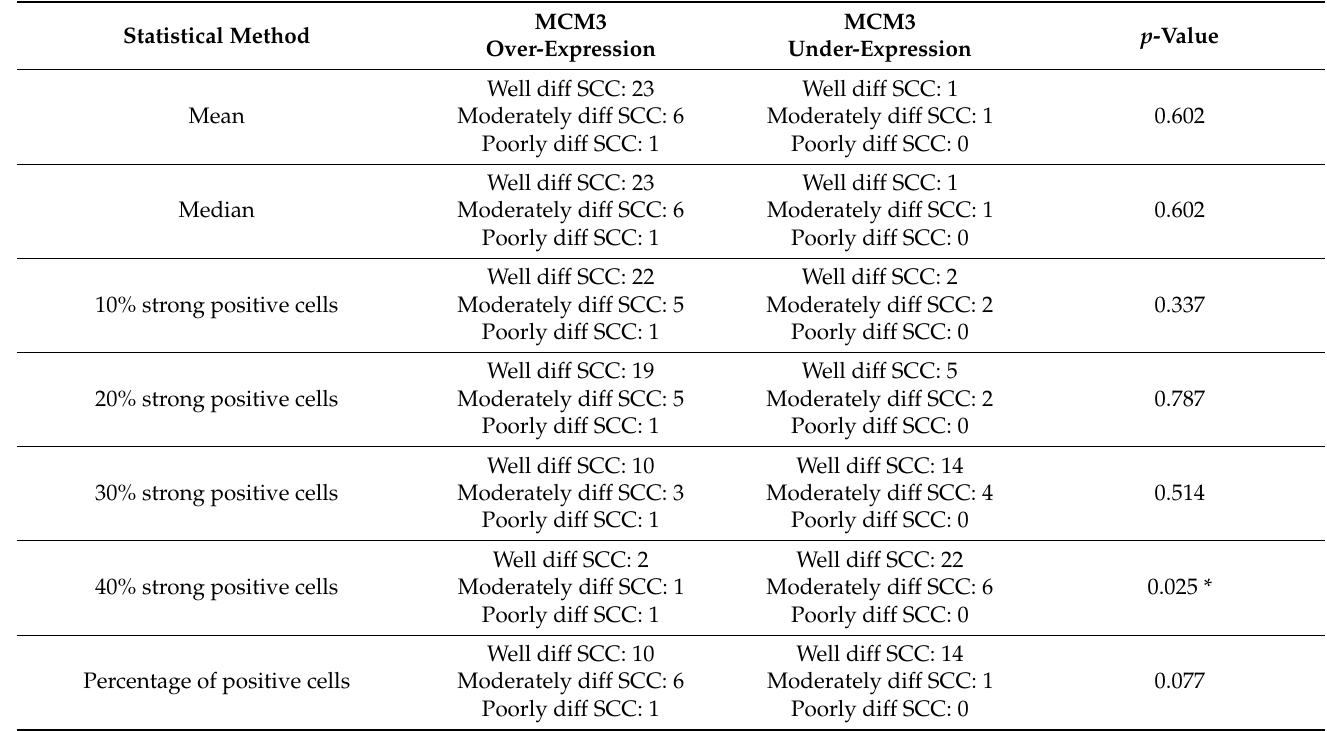
Table 6. MCM3 correlation with Broder’s grading